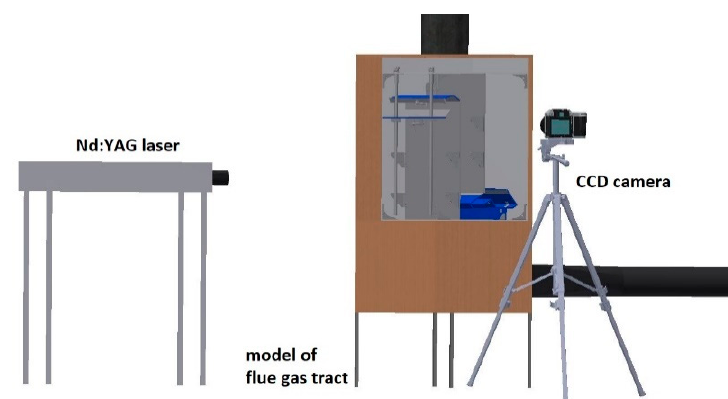
Figure 3. The experimental set-up.